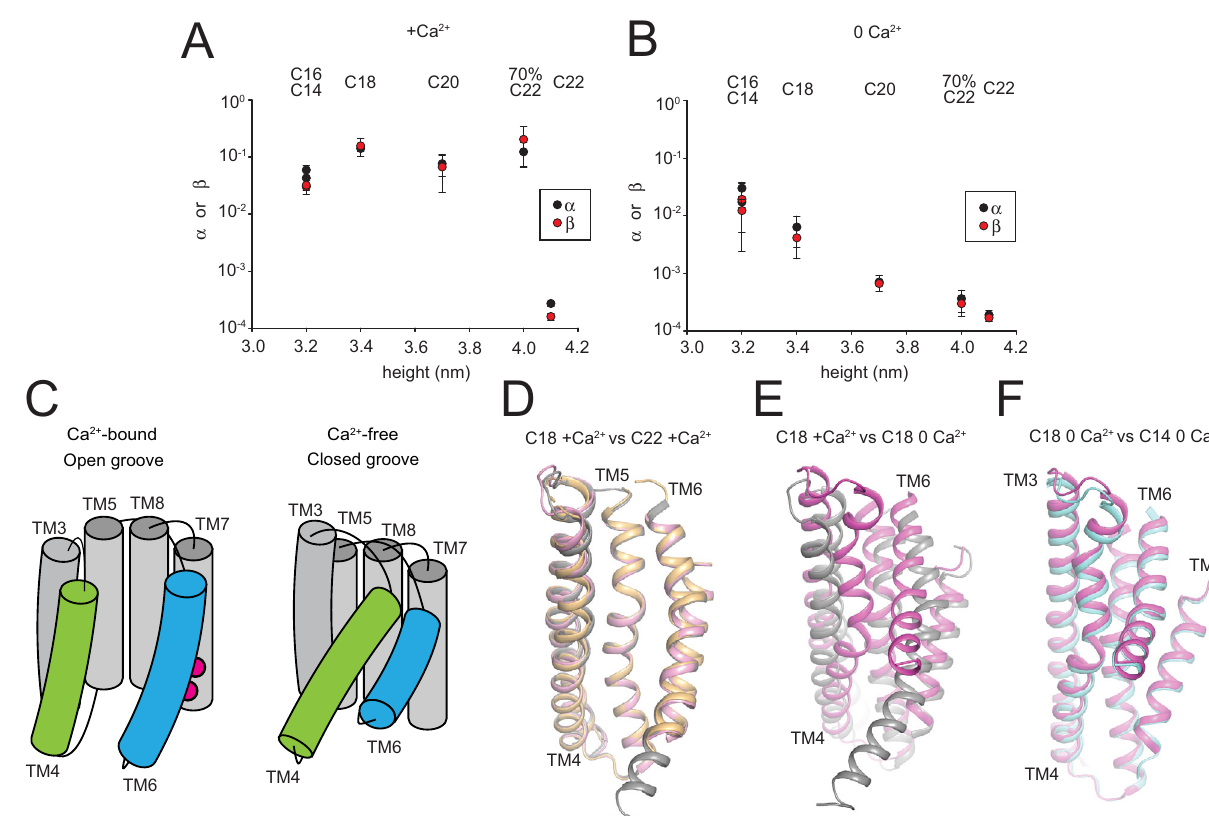
Fig. 4 Functional and structural regulation of lipid scrambling by membrane thickness. A , B Forward ( α , black circles) and reverse ( β , red circles) scrambling rate constants as a function of membrane thickness in the presence of 0.5 mM ( A ) or 0 Ca 2 + ( B ). Values are the mean determined from n = 8 – 15 independent determinations from N = 3 – 5 independent preparations and error bars represent St. Dev. Corresponding lipid compositions are noted above. Values for C18 and C22 were determined in another study and are reported here for comparison 20 . Source data is available in the Source Data fi le. C Cartoon representation of the permeation pathway showing movements of TM4 (green) and TM6 (blue) during Ca 2 + -gating. D – F Alignment of the permeation pathway of afTMEM16 in ( D ) in 0.5 mM Ca 2 + and C18 (gray), C22 MSP1E3 nanodiscs (light pink) and C22 MSP2N2 nanodiscs (orange), ( E ) C18 nanodiscs in 0.5 mM (gray) and 0 Ca 2 + (pink), ( F ) in 0 Ca 2 + in C18 (red) and C14 nanodiscs (cyan). Source data are provided as a Source Data fi